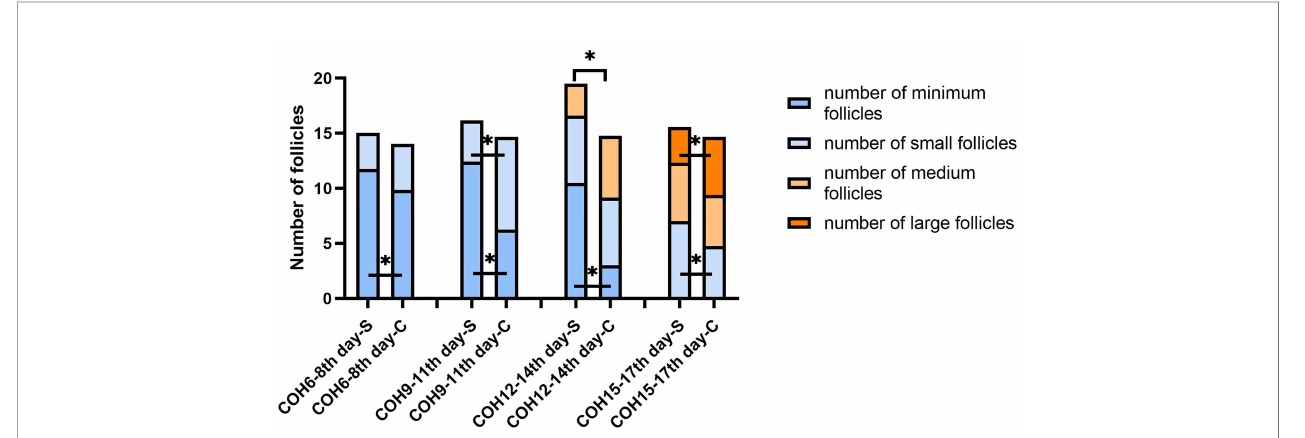
± 2.50 IU/l, higher than 1.91 ± 1.16 IU/l in the control group ( Figure 5B ) ( Supplementary Table 3 ). The level of LH/FSH ratio of the SOR group on day 2 of COH was 0.54 ± 0.30, also signi fi cantly lower than 0.87 ± 0.88 in the control group (P < 0.05) ( Supplementary Table 3 ). The levels of serum E2 of the SOR group on COH days 6 – 8 and 9 – 11 were 430.19 ± 314.40 pmol/l and 1,170.88 ± 1,138.11 pmol/l, respectively, lower than 2,150.61 ± 2,790.17 pmol/l and 5,933.60 ± 4,309.70 pmol/l in the control group ( Figure 5A ). The level of serum P of the COH SOR group was 1.16 ± 0.47 nmol/l, lower than 1.88 ± 0.85 nmol/l in the control group on COH days 9 – 11 (P < 0.05) ( Figure 5C ). The PFI and P/E2 ratio in the SOR group on the HCG day were not statistically different ( Supplementary Table 3 ). The minimum follicle number in the SOR group on days 6 – 8, 9 – 11, and 12 – 14 of COH was higher than that of the control group (12.28 ± 5.10 vs. 9.14 ± 5.80, 10.41 ± 5.68 vs. 5.81 ± 4.04, 9.50 ± 5.09 vs. 3.00 ± 1.00, respectively) (P < 0.05), and the number of large follicles in